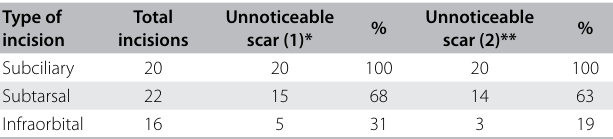
Table 1. Unnoticeable scar rates associated with each type of